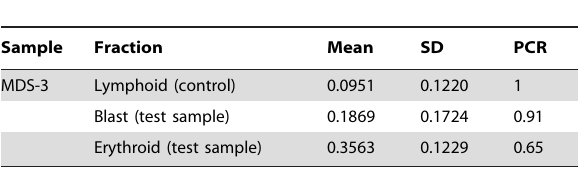
Table 2. Output of the CMA algorithm results for a region located in chromosome 7q34 and the corresponding real-time PCR